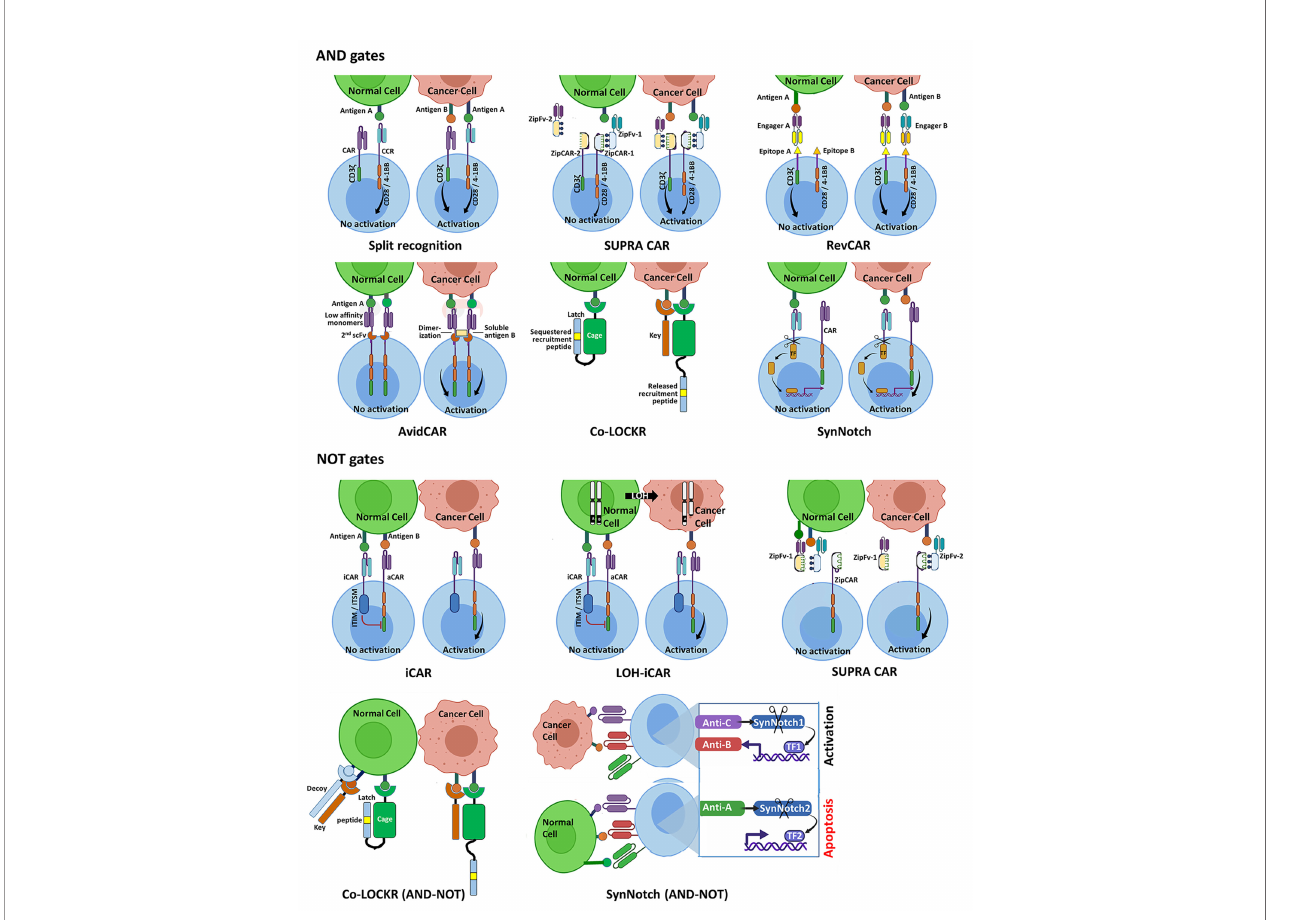
FIGURE 1 | Schematic representation of selected Boolean logic AND and NOT gate strategies for integrating two or three antigenic cues, designed to enhance precision of CAR-T cell therapy of cancer. AND gates . The split recognition strategy involves one receptor with an activation domain and a second receptor with a co-stimulatory domain, each speci fi c to a different antigen. Full T cell activation is only achieved upon simultaneous engagement of the two receptors with their respective antigens. Each SUPRA CAR system utilizes a universal CAR-like receptor (zipCAR) carrying a leucine zipper, which can bind a corresponding leucine zipper incorporated onto a soluble antigen-speci fi c zipFv protein, enabling multiplexed control of T cell responses. Shown here are zipCAR-1, equipped with a leucine zipper speci fi c to that of zipFv-1, which recognizes antigen A that is shared by the tumor and normal cell, and zipCAR-2, speci fi c to zipFv-2 and to antigen B that is expressed by the tumor cell but not by the same normal cell. RevCARs are economical CAR constructs, harboring peptide epitopes instead of scFvs. The RevCAR platform utilizes bi-speci fi c engagers, each comprising two scFvs: one speci fi c to a distinct peptide epitope and the other recognizing a tumor-associated antigen. Shown here are a T cell co-expressing two different RevCARs, each harboring a different peptide epitope and either T cell activation or costimulatory domain, and two engagers, each directed at a given peptide epitope and a tumor antigen. The T cell can only be activated when the two engagers are simultaneously bound to their tumor antigens. AvidCAR is an avidity-controlled CAR platform, designed to homodimerize upon dual antigen recognition conferring suf fi cient avidity for T cell activation. The Co-LOCKR gate utilizes a universal CAR speci fi c to a recruitment peptide, which is placed in a ‘ Latch ’ sequence. The latch itself is linked to a soluble ‘ Cage ’ protein that is directed at fi rst tumor antigen. The recruitment peptide is normally sequestered by the Cage and is only exposed to engagement by the CAR when a competing ‘ Key ’ protein binds a second antigen present on the same tumor cell. The synNotch AND gate comprises a constitutively expressed module which releases a synthetic TF only upon binding of antigen A. Upon translocation to the T cell nucleus, this TF drives the expression of a conventional CAR speci fi c to antigen B. NOT gates . The iCAR and the LOH-iCAR typically utilize an inhibitory element derived from a T/NK cell inhibitory receptor. Binding of the iCAR to the inhibitory antigen would prevent T cell activation that could otherwise take place following engagement of the aCAR with the activating antigen. The SUPRA CAR NOT module operates through competition: when both zipFv-1 and zipFv-2 proteins bind their respective antigens A and B on normal cells, their complementary leucine zippers are tightly engaged, precluding activation of the zipCAR. T cell activation can only take place upon encounter with tumor cells, in the absence of competition by non- bound zipFv-1. The Co-LOCKR NOT circuit implements a combination of AND and NOT gates and functions through competition, employing a third protein (in addition to the Cage and Key proteins) that binds speci fi cally to a third antigen present on normal but not tumor cells. This protein possesses a Decoy element, which binds Key with high af fi nity. When all three proteins are engaged with their target epitopes on the surface of a normal cell, Key is prevented from binding to Cage so that release of the recruitment peptide does not take place. The synNotch circuit shown here utilizes a suicide module, which is only activated upon encounter with an inhibitory antigen expressed by the normal cell to be